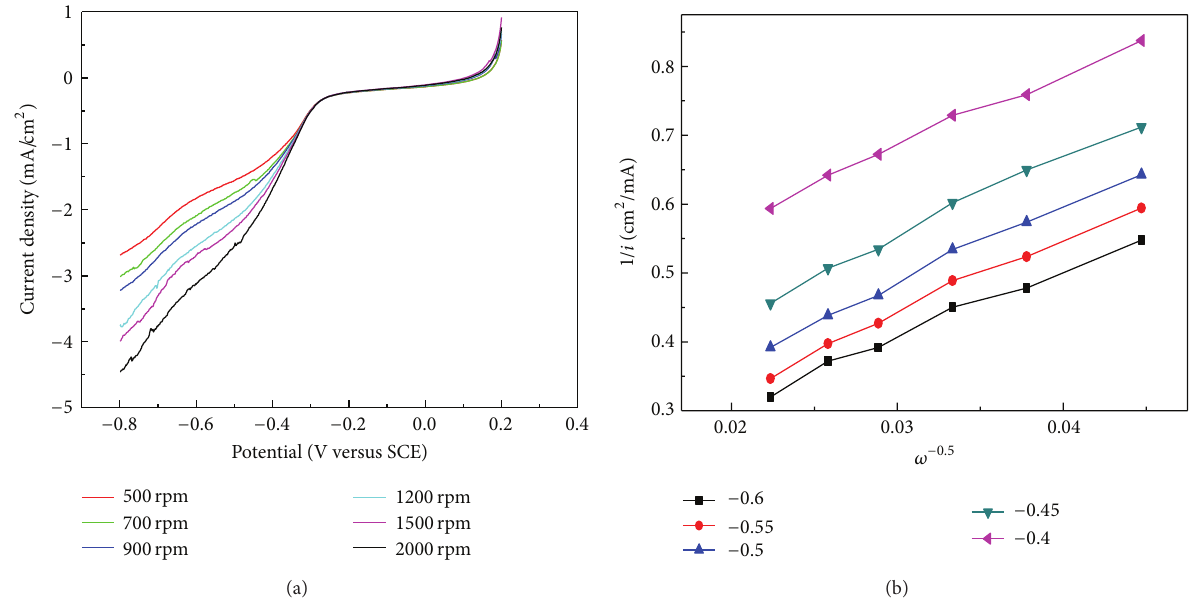
Figure 3: LSV plots at different rotation rates and corresponding Koutecky-Levich plots of sample Biochar-act900 at a scan rate of 100mv/s.